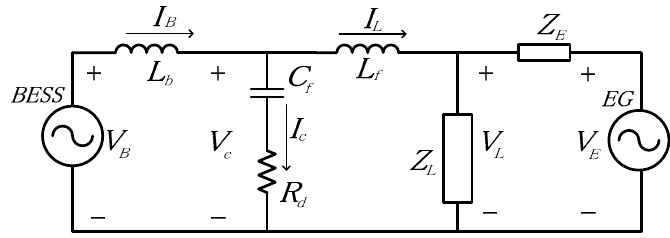
Figure 4. Equivalent circuit of the entire system.